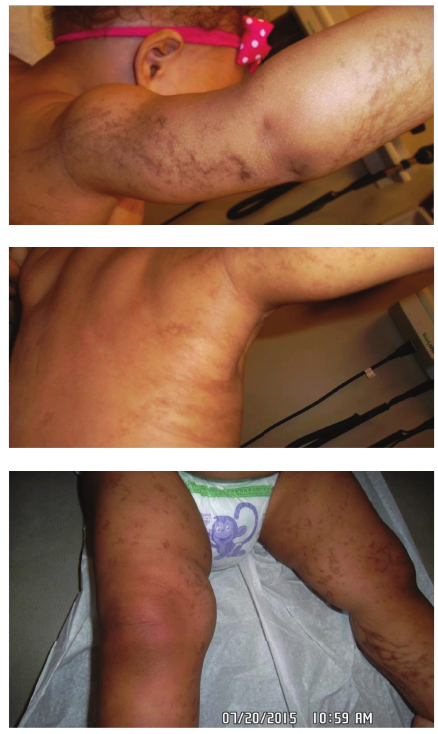
Figure 2: Hyperpigmented lesions on both upper and lower extremities at 12-month visit.